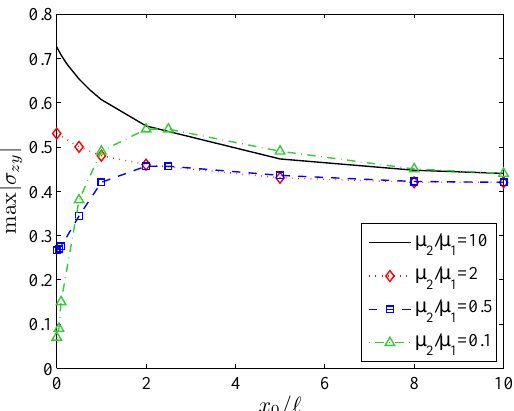
Figure 4: Dependence of max | σ zy | on the normalized dislocation position x / l for l and different values of µ 1 = l 2 = l values are given in units of µ 1 b /(2 πl 1 )